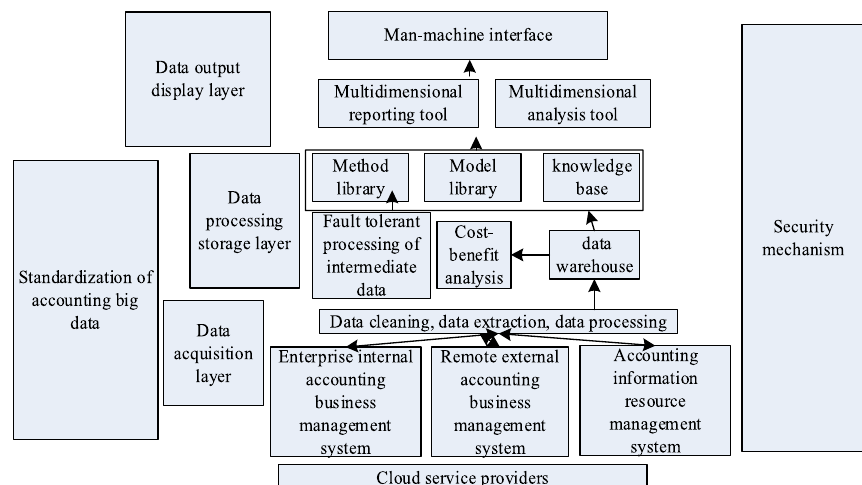
Fig. 1 Cloud computing accounting service platform